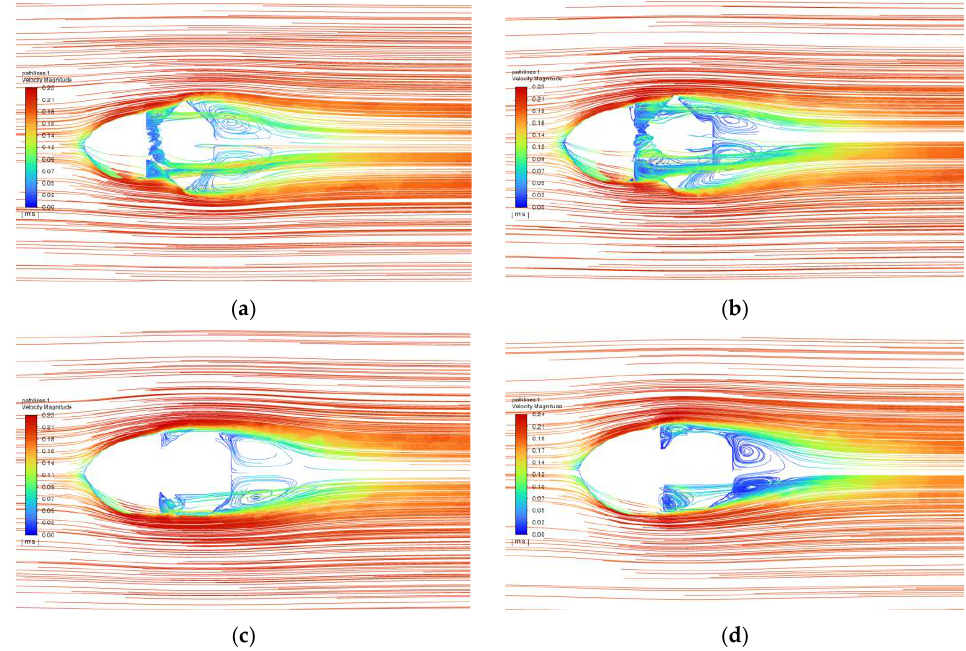
Figure 2. Path lines of the bionic jellyfish robot with the given four origami variants at 0.2 m/s . ( a ) rhombic dodecahedron hemisphere structure; ( b ) rhombic dodecahedron structure; ( c ) rhombic triacontahedron hemisphere structure; ( d ) rhombic triacontahedron structure.